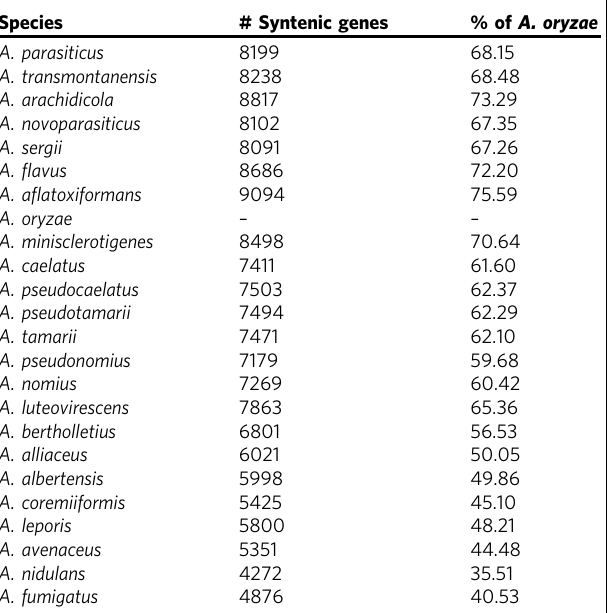
Table 1 Percentage of genome with conserved synteny relative to A. oryzae